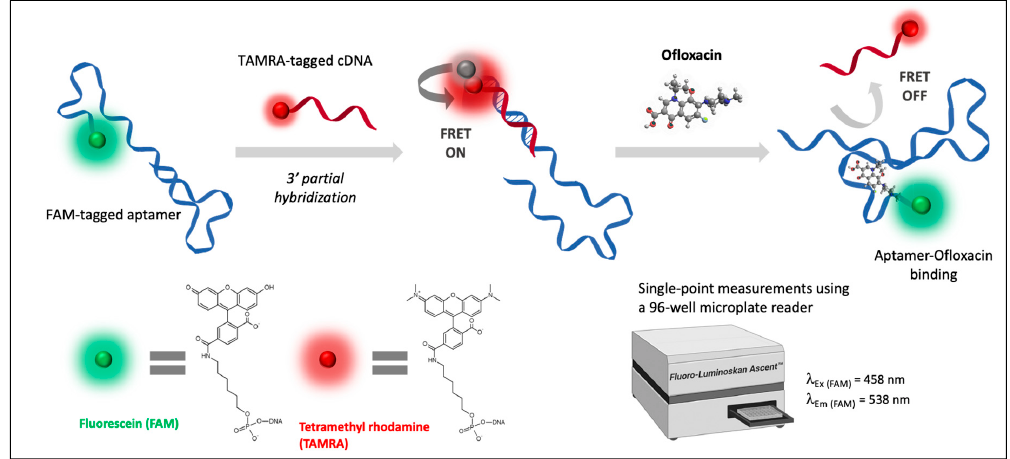
Figure 4. Schematic principle of the FRET-based apta-assay for the detection of ofloxacin.